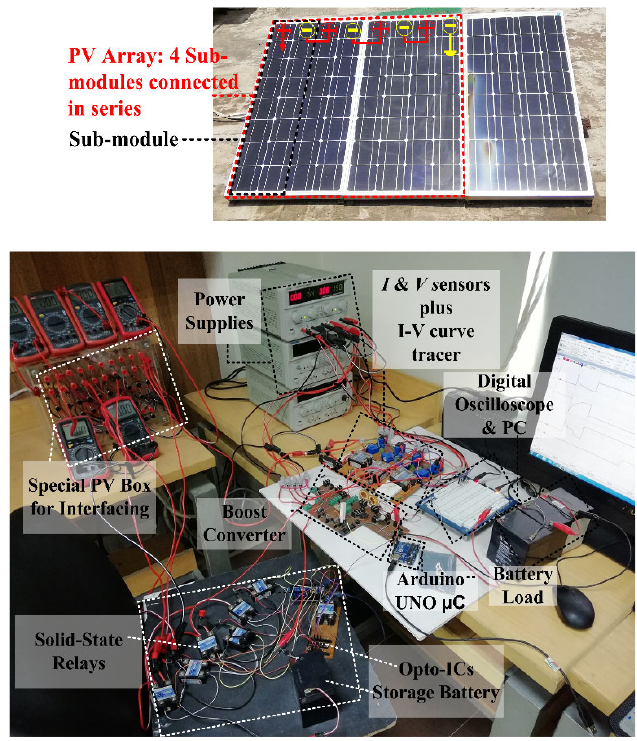
Figure 14 . Complete hardware apparatus of proposed hardware scheme along with labels . Figure 14. Complete hardware apparatus of proposed hardware scheme along with